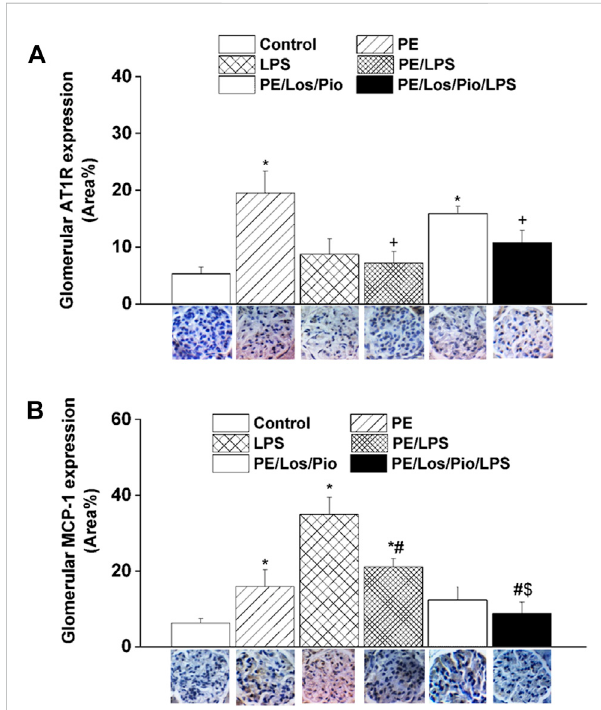
FIGURE 8 Effect ofcombined gestational losartan and pioglitazone therapy on immunohistochemical protein expressions of AT1 receptors (panel A ) and MCP-1 (panel B ) in renal glomerular tissues of male offspring of PE or PE/LPS dams. The One-way ANOVA followed by the Tukey ’ s post hoc was utilized to measure statistical signi fi cance. Values are expressed as means ± S.E.M of 5 observations. * p < 0.05 vs. “ Control ” , # p < 0.05 vs. “ LPS ” , + p < 0.05 vs. “ PE ” , $ p < 0.05 vs. “ PE/LPS ” values. Representative images for immunostained renal glomerular tissues are shown below bar